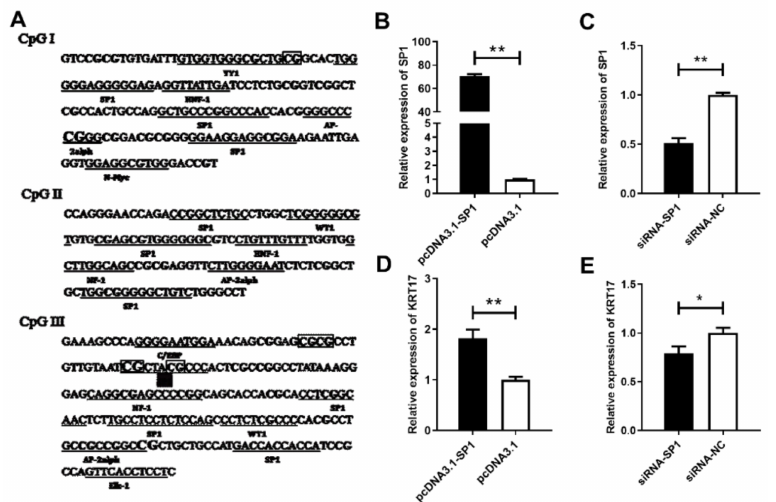
Figure 8. SP1 regulates KRT17 expression. ( A ) predictive transcription factor binding sites in CpG islands of KRT17 promoter; ( B ) SP1 overexpression; ( C ) SP1 interference; ( D ) SP1 overexpression; and ( E ) interference effect on KRT17 expression. ** p < 0.01. * p <